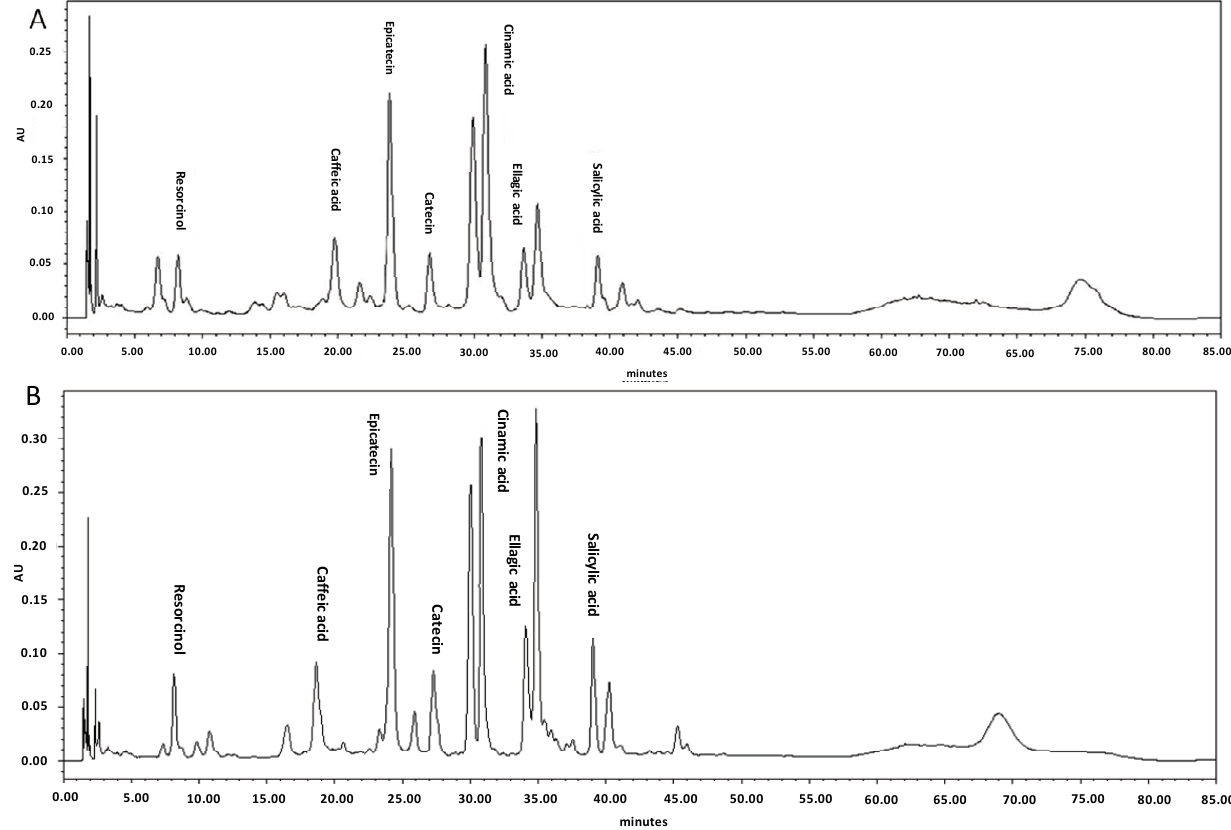
Figure 1. ( A ) The HPLC chromatogram of phenolic compounds in the non-treated leaves of C. alismatifolia var. sweet pink ; ( B ) The HPLC chromatogram of phenolic compounds in the leaves of C. alismatifolia var. Sweet pink under 20 Gy acute gamma irradiation. Compound identification as labeled (concentration: 1